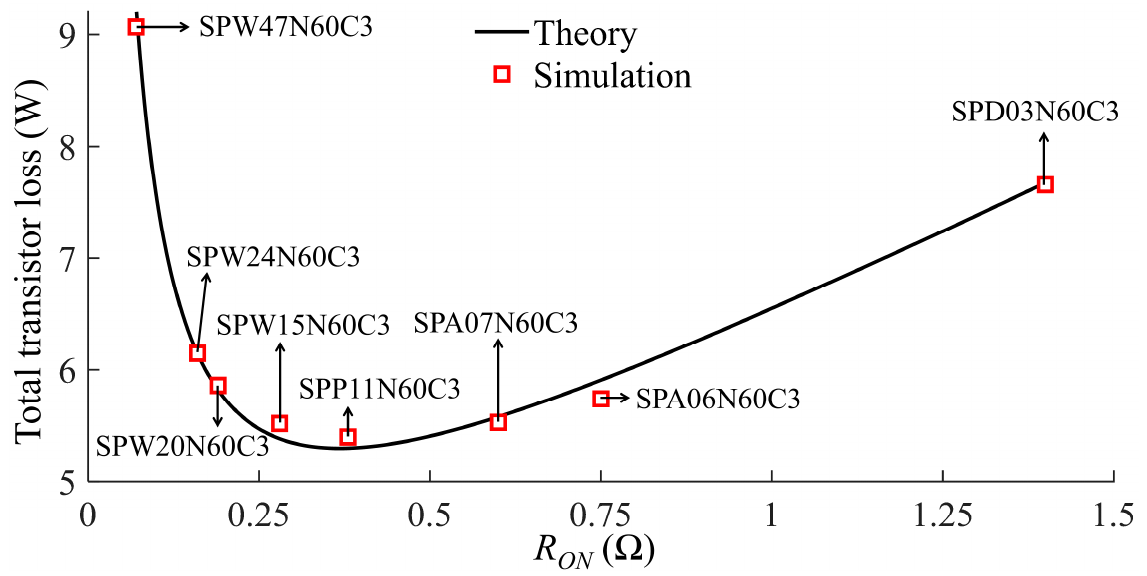
Figure 4. Comparison of the proposed theory with LTSPICE simulation on clamped inductive load circuit.